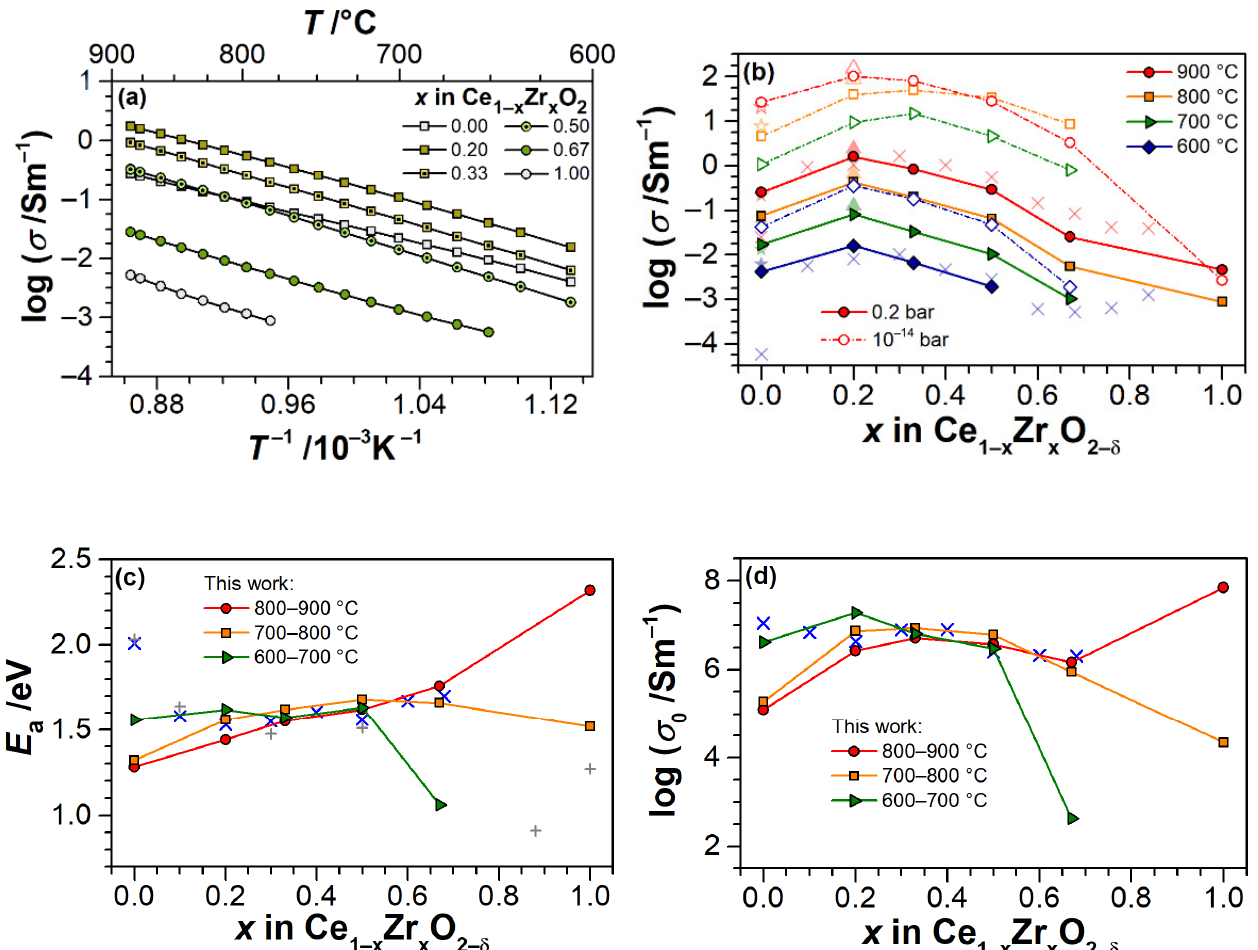
Figure 4. Electrical conductivity of Ce 1 − x Zr x O 2 thin films as a function of temperature and Zr fraction: ( a ) obtained during cooling in air; ( b ) variation with Zr fraction in air (solid symbols) and at p O 2 = 10 − 14 bar (open symbols) in comparison to CeO 2 − δ nanofilms (Kosacki, et al. [56], stars), nanostructured bulk Ce 0.8 Zr 0.2 O 2 − δ (Chen, et al. [32], up-triangles), and bulk Ce 1 − x Zr x O 2 (Chiodelli, et al. [35], crosses, air); ( c ) dependences of E a on x in comparison to data from Chiodelli, et al. [35] (crosses) and from Lee, et al. [63] (pluses) and ( d ) dependences of σ 0 on x compared to data from Chiodelli, et al. [35] (crosses). The analysis of absolute values of total electrical conductivity in air shows the highest conductivities for x ≤ 0.5 with a maximum attained in samples with 20 mol.%. ZrO